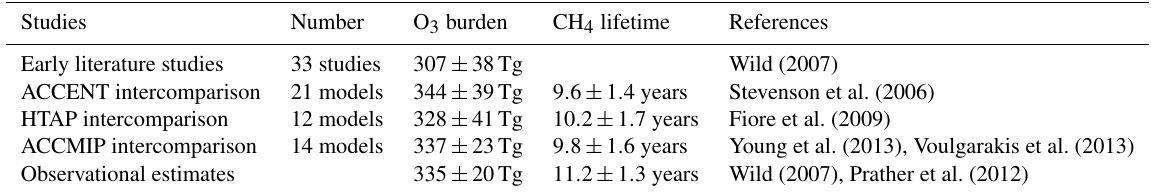
Figure 1. Tropospheric oxidant budgets from previous published studies and model intercomparisons (a) , along with measurement-based estimates of the tropospheric O 3 burden and CH 4 lifetime (shaded regions). Panel (b) shows results from one-at-a-time sensitivity studies with a single model revealing the extent to which individual processes can influence the budgets (see Wild, 2007, for details). Note that results in (a) represent differing emissions and meteorological years (study details are given in Table 1) and that (b) covers only part of the parameter space shown in (a) . Table 1. Global tropospheric metrics from previous model